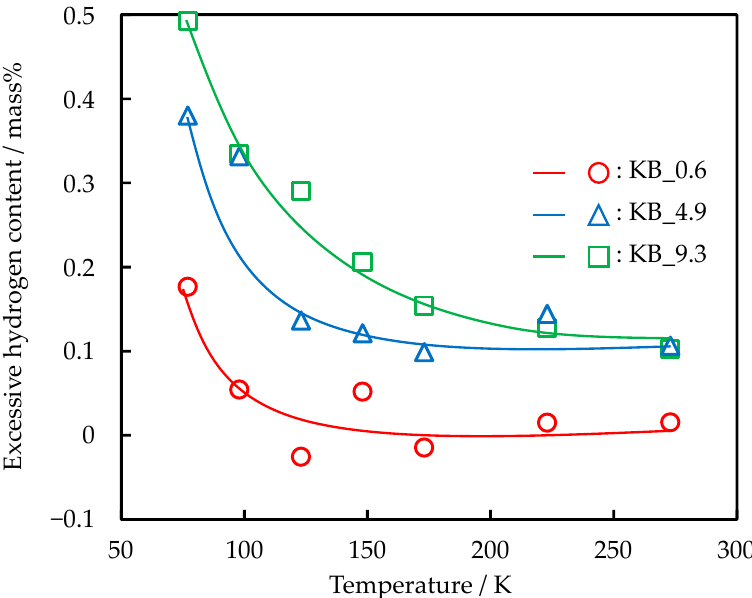
Figure 8. Variation of excessive hydrogen content under 0.8 MPa of hydrogen with temperature for KB_0.6, KB_4.9, and KB_9.3. The excessive hydrogen content at 273 K of KB_0.6 is calculated from the saturated hydrogen contents of KB under 0.38 MPa and KB_0.6 under 0.42 MPa. The absolute values of enthalpy changes (| ∆ H |) and entropy change (| ∆ S |)